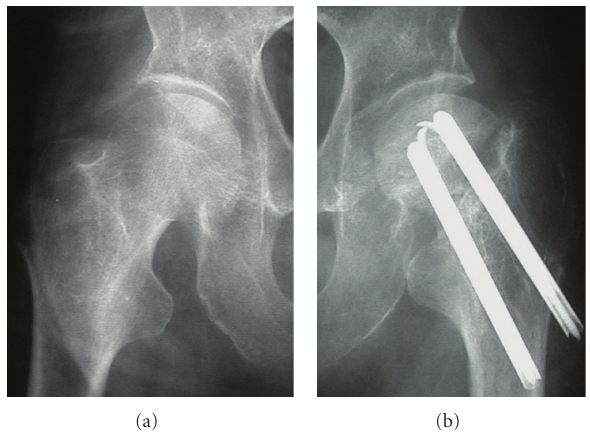
Figure 1: Radiographs show irregularity of the surface of the left acetabulum and osteoporotic changes of the superior part of the left acetabulum in comparison with the right hip. There is an obvious pseudoarthrosis of the femoral neck after internal fixation.